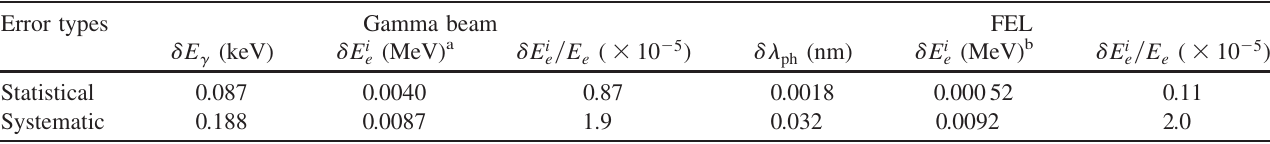
TABLE II. Uncertainty of the electron beam energy measurement at the storage ring set energy of 461.06 MeV. Error types